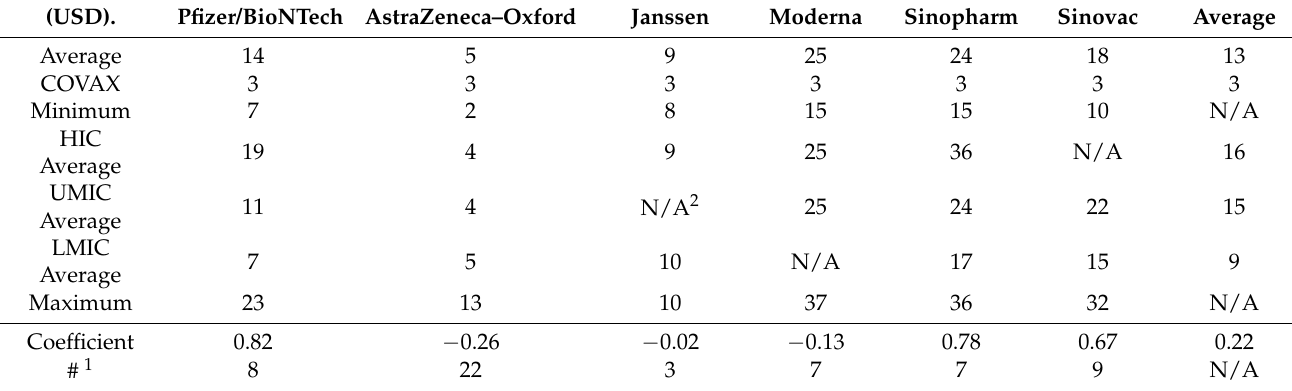
Table 5. Average vaccine prices and correlation between GDP per capita and vaccine prices (USD).